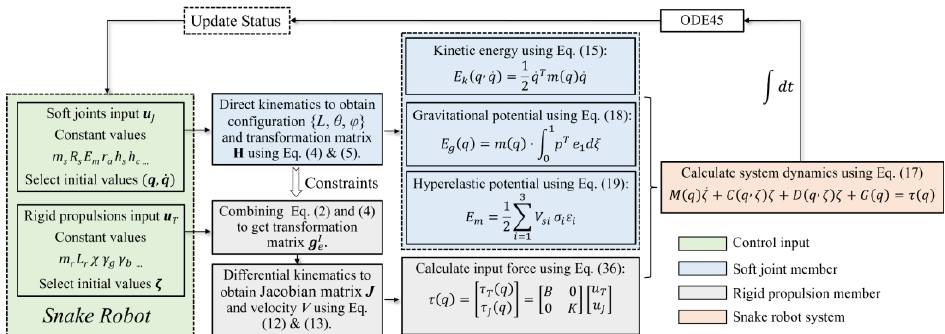
Figure 6. Flowchart of the solution for the dynamic equations.